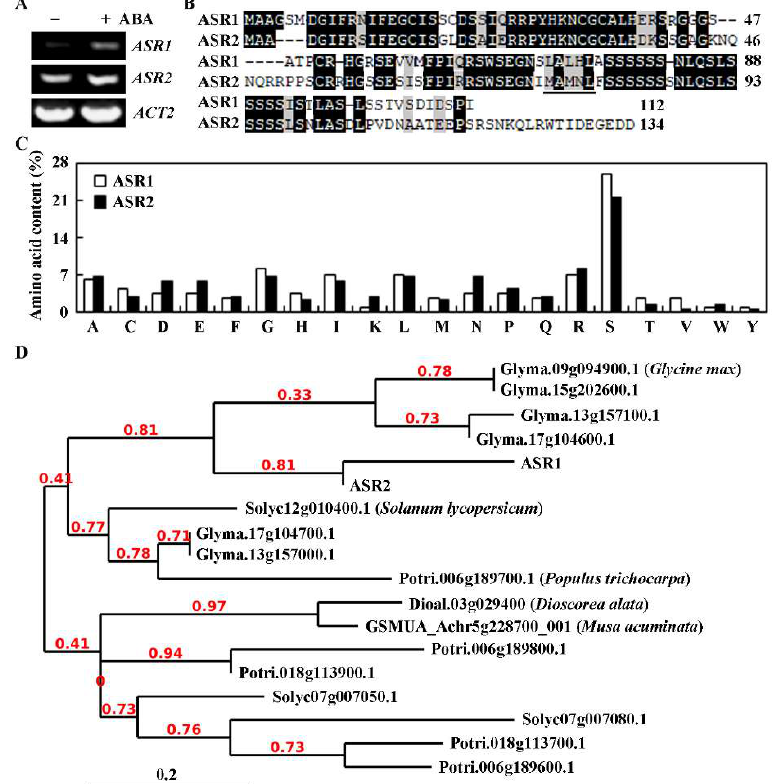
Figure 1. Expression of ASR1 and ASR2 in response to ABA treatment and amino acid sequence analysis of ASR1 and ASR2. ( A ) Effects of ABA on the expression of ASR1 and ASR2. Ten-day-old seedlings of the Col wild-type Arabidopsis were treated with 50 μM ABA for 4 h, RNA was isolated, and RT-PCR was used to examine the expression of ASR1 and ASR2 . ACT2 was used as a control. ( B ) Amino acid sequence alignment of ASR1 and ASR2. Full length amino acid sequences were subjected to sequence alignment by using BioEdit. The identical amino acids were shaded in black, and the similar ones in gray. Under line indicates the LxLxL motif in ASR1. ( C ) The percentage of amino acid content of ASR1 and ASR2. Amino acid content was analysis on NovoPro (https://www.novopro.cn/tools/protein_stats.html, accessed on 25 December 2022). ( D ) Phylogenetic analysis of ASRs and their homologues from several different plants. Full-length amino acid of ASRs and their homologs were subjected to phylogenetic analysis by using “one click” mode with default settings on phylogeny (https://www.phylogeny.fr/, accessed on 7 February 2023). genes are enriched in the amino acid serine (Figure 1B), the content of which is more than 20% of the total amino acids in both proteins (Figure 1C). In addition, both proteins